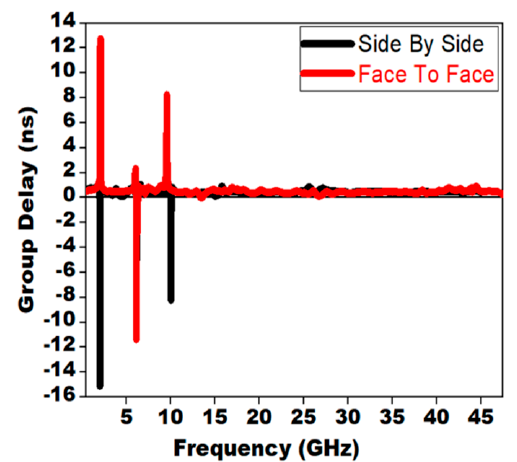
Figure 17. Group delay for proposed band notch antenna for side-by-side and face-to-face configu- rations.